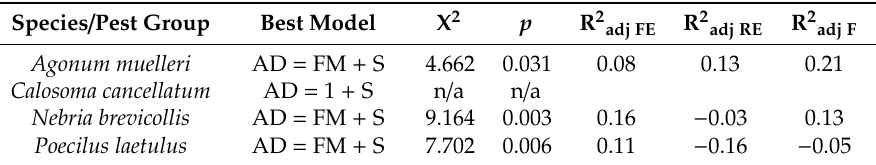
Table 3. Results of the generalized linear mixed model analysis showing the best scoring model for each carabid species. Shown are the Χ 2 and p-value of the comparison with the model containing only the random effect ‘site’ following parametric bootstrapping (N = 10,000) as well as the adjusted R 2 values of the fixed effect (FE), random effect (RE) and full model (F).